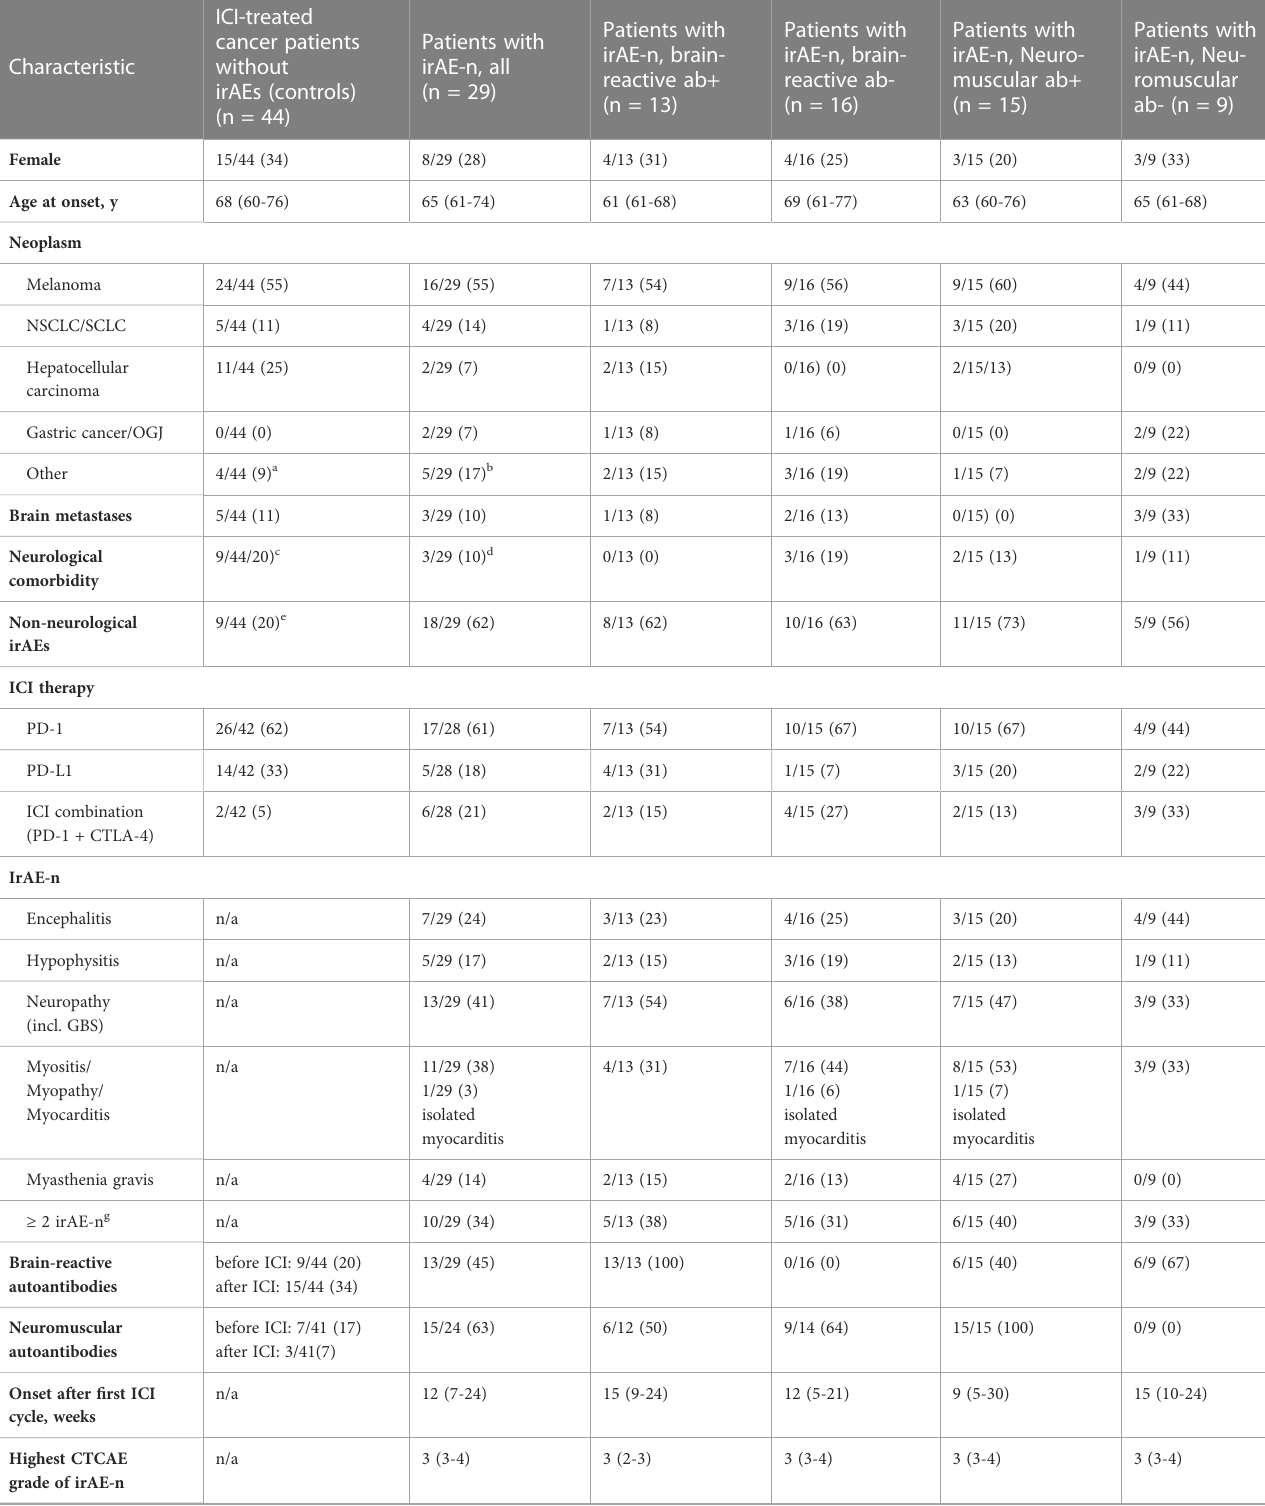
TABLE 1 Characteristics of ICI-treated cancer patients with and without neurological irAEs.